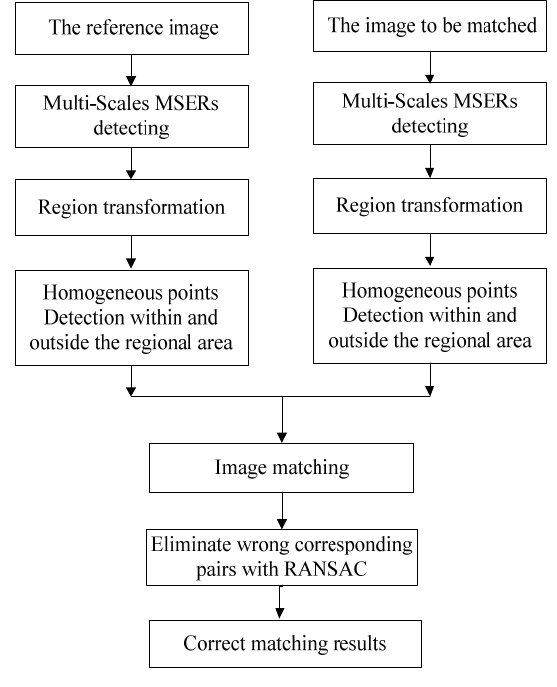
Fig.6 Flowchart of the proposed matching